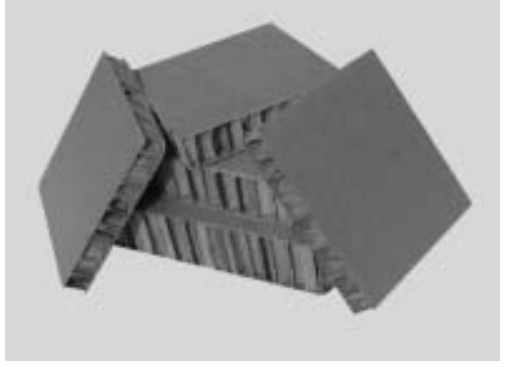
Fig. 1. Photograph of the honeycomb paperboards.